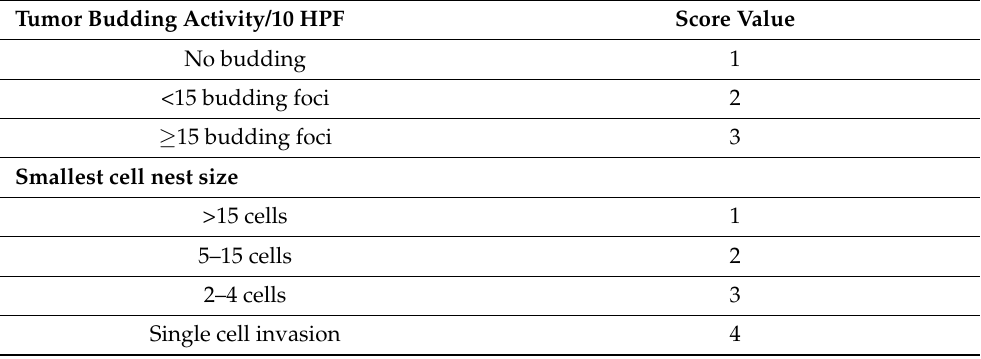
Table 3. Tumor cell budding system used in our study to determine tumor grade based on tumor budding activity and cell next size score adapted from human cervical squamous cell carcinoma (SCC) (Jesinghaus et al., 2018) [7] and laryngeal/hypopharyngeal SCC (Boxberg et al., 2019) [8]. Tumor Budding Activity/10 HPF Score Value No budding 1 <15 budding foci 2 ≥ 15 budding foci 3 Smallest cell nest size >15 cells 1 5–15 cells 2 2–4 cells 3 Single cell invasion 4